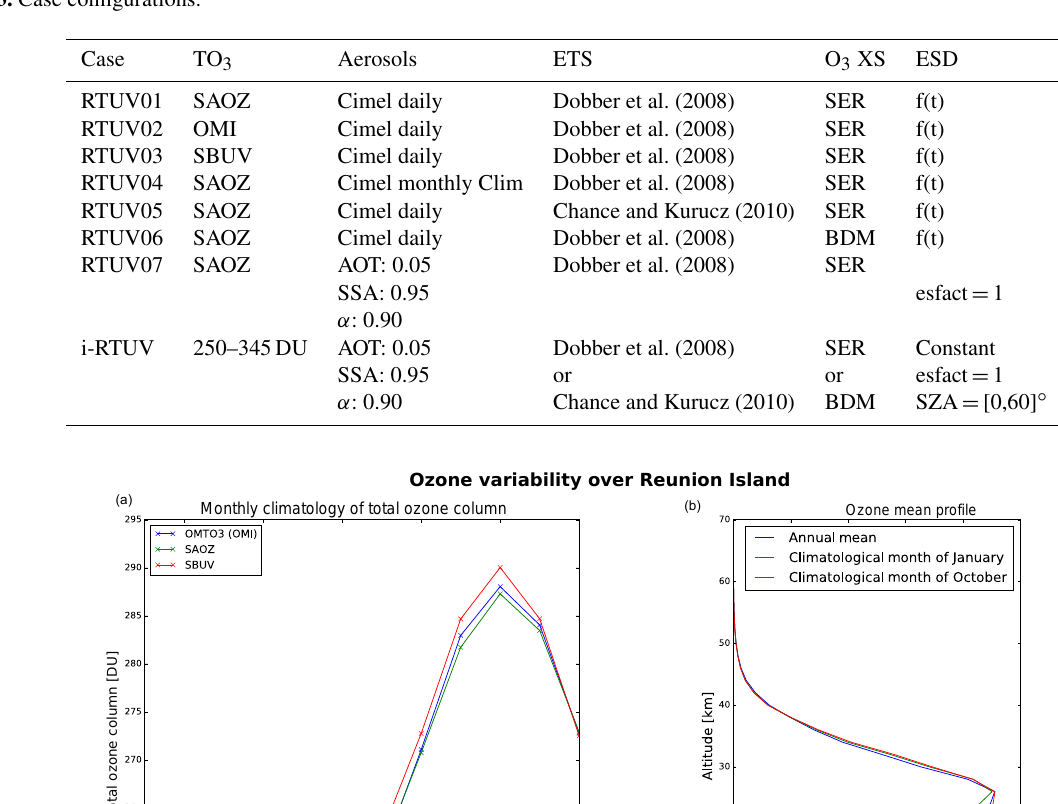
Table 3. Case configurations.